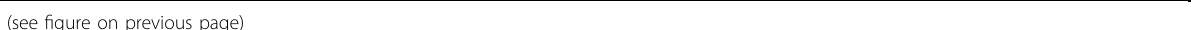
Fig. 6 Keratoconus-related changes in cell – cell communications. a Expression pro fi les for YAP signaling pathway components in CSC and CEC subclusters. b Expression changes of YAP1 in CSC and CEC subclusters of keratoconus samples. ** P < 0.01, **** P < 0.0001 (two-sided Wilcoxon rank- sum test). c Chord diagram of cellular interactions between ImCs/CECs and CSCs from Ctrl and KC samples, separately. The number of interaction pairs and cell types are annotated. d Dot plot of erased ligand-receptor interactions associated with CSCs in KC samples compared to that in Ctrl samples. CSCs express receptors and receive ligand signals from CECs/ImCs. The row represents a ligand-receptor pair and the column de fi nes a cell- cell interaction. The samples of Ctrl or KC are annotated in the brackets. P values and means was calculated by CellphoneDB pipeline. The dot size re fl ects the P values for cell type-speci fi city, and the dot color denotes the mean of the average ligand-receptor expression in the corresponding interacting cell types. The pairs mentioned in the text are in dashed boxes. e Bar graph of the expression of IL1RN in ImCs and IL1R1 in CSCs. f NicheNet interaction heatmap between ImCs/CECs and CSCs in KC samples. Left, heatmap of average log 2 FC of the top predicted ligands expression between KC and Ctrl samples for CECs/ImCs. Bottom, heatmap of average log 2 FC of ligand-matched targets expression between KC and Ctrl samples for CSCs. Middle, heatmap of predicted ligand-target regulatory